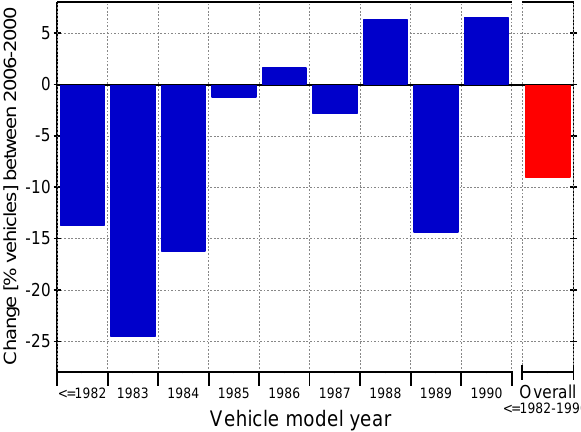
Fig. 6. Percentage change in the number of vehicles models-year 1990 to < =1982 (that is, vehicles without emission control devices) between 2006 and 2000 in Mexico City. Data adapted from SMA